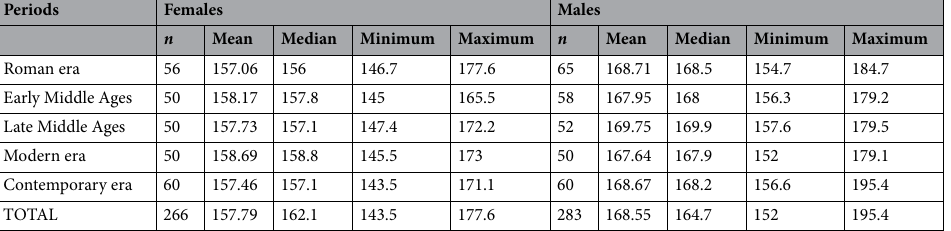
Table 2. Descriptive statistics of the study sample.